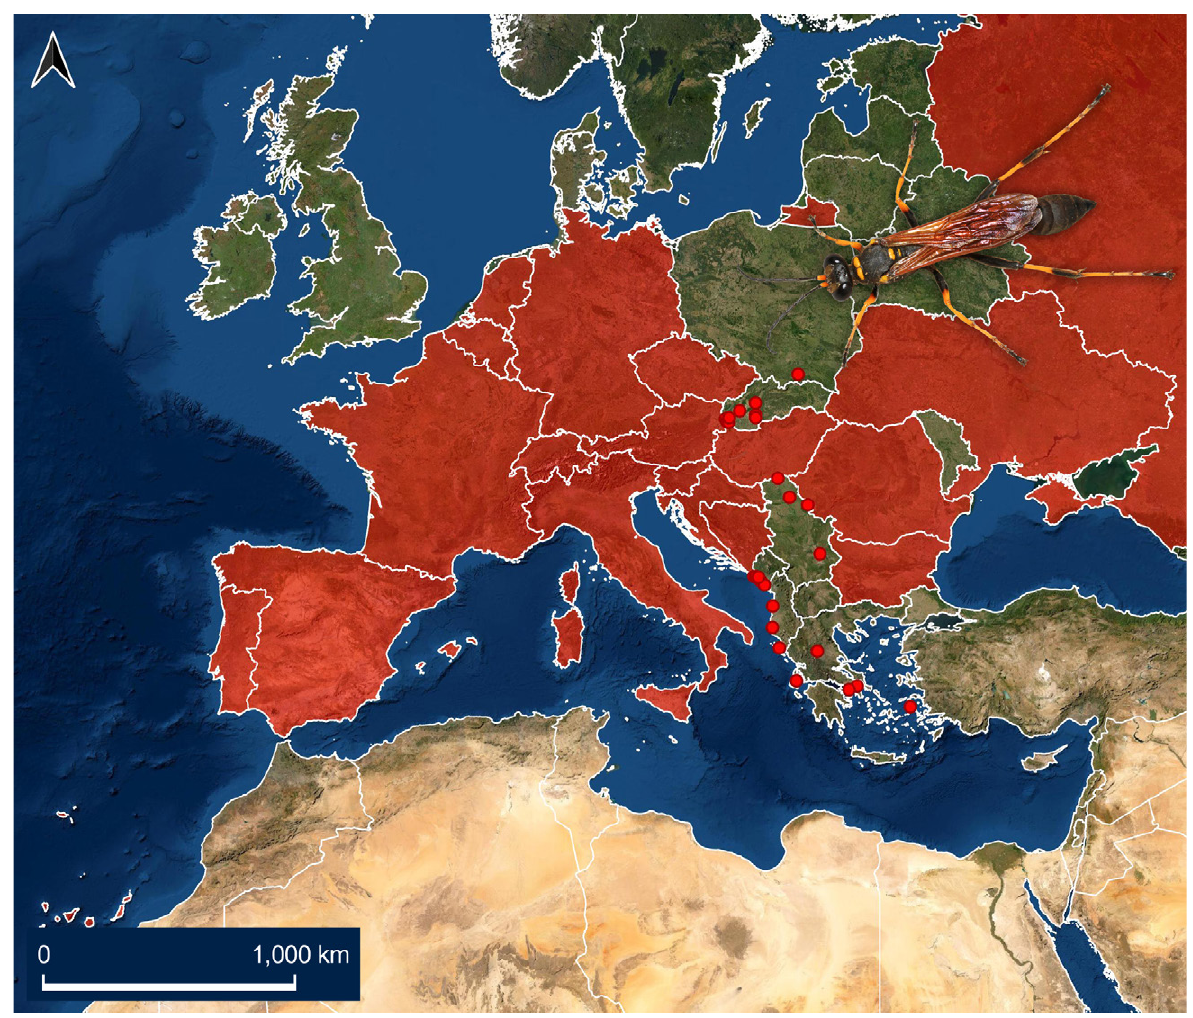
Figure 2. Current known distribution of the alien Sceliphron caementarium (Drury, 1773) in the study area. Countries where the species has been previously reported are shaded red, while new records are depicted with dots. The map was created with QGIS, v. 3.14.16. Inset: S. caementarium (photo by Judy